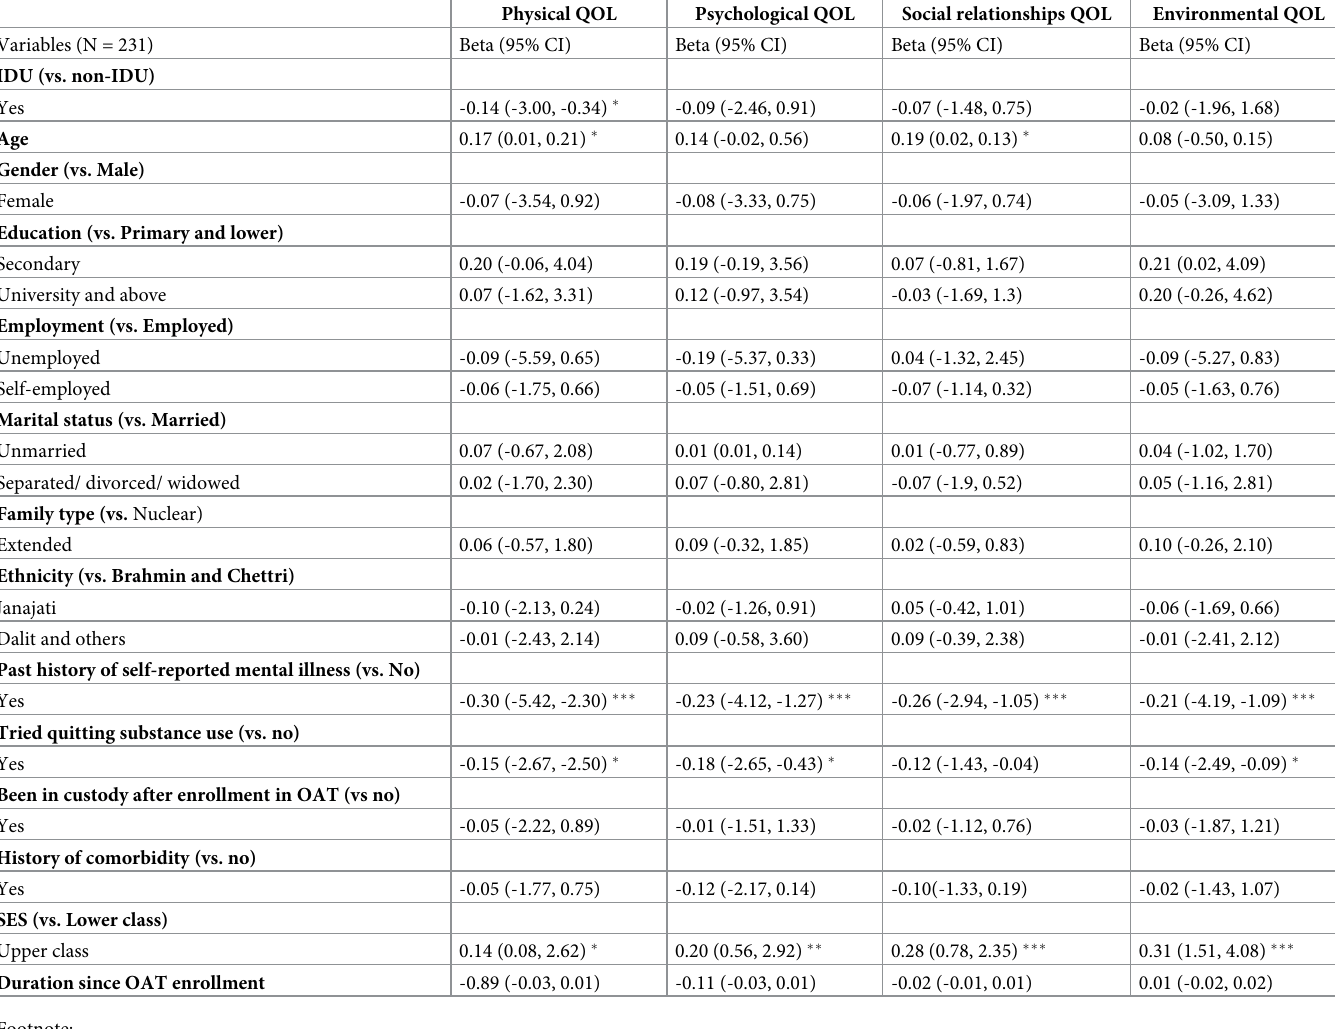
Table 5. Factors associated with Quality of life